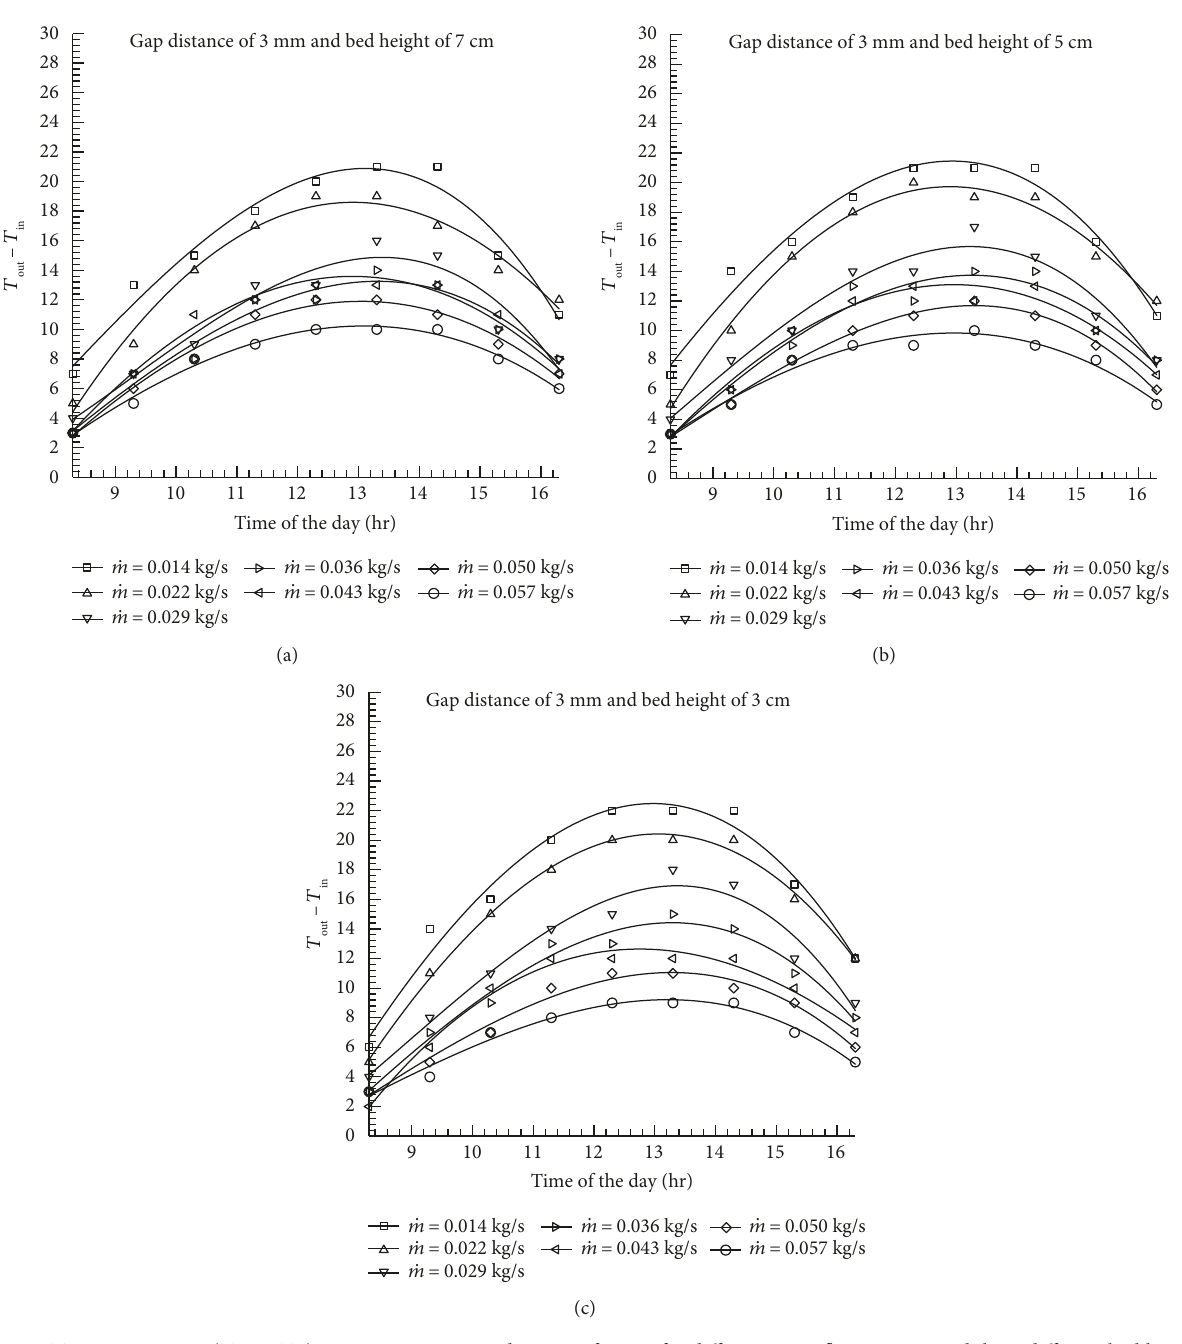
Figure 7: Temperature rise ( T (a) 7 cm, (b) 5 cm, and (c) 3